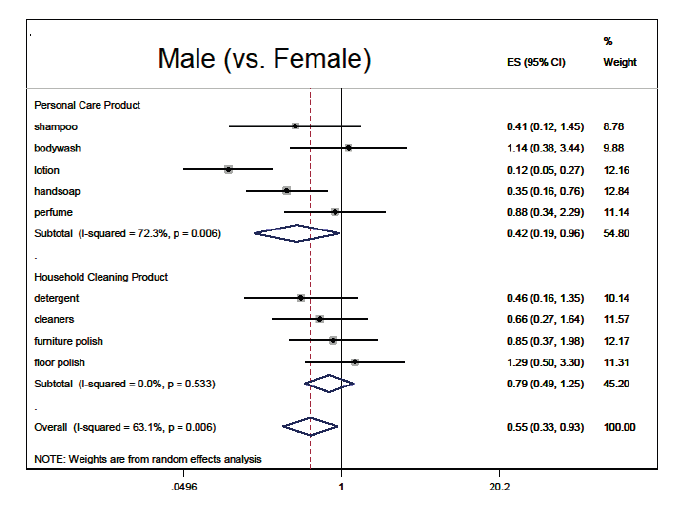
Figure 4. Demographic predictors of fragranced product use (meta-analysis of multivariable model results): male ( vs. female). Models are ordered logistic regressions with random intercepts for twin pair and address, with fixed effects for age, sex, education, ever being bothered by fragrance and race, restricted to white participants only ( N = 280). Missing data were imputed by multiple imputation with chained equations. Model estimates are combined by random-effects meta-analysis by product